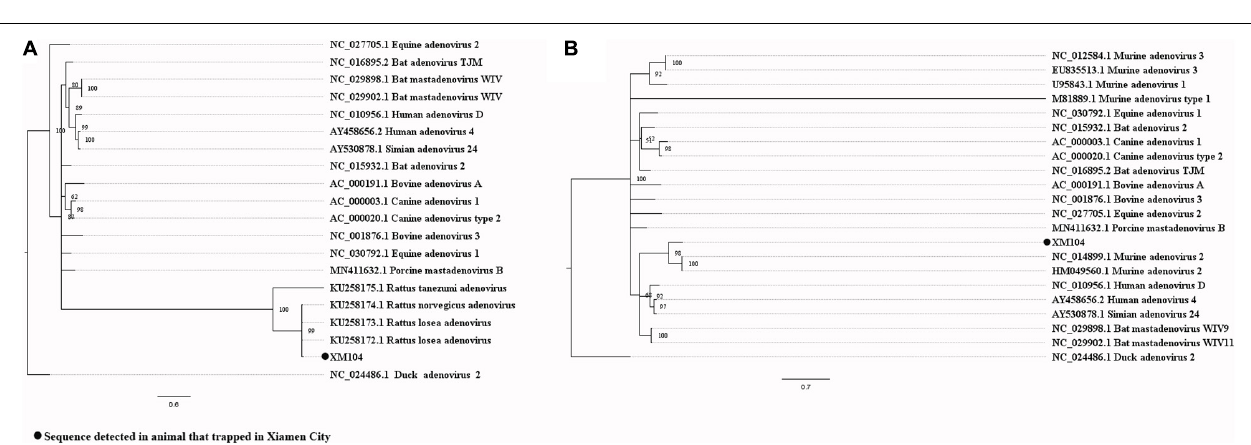
Frontiers in Microbiology |